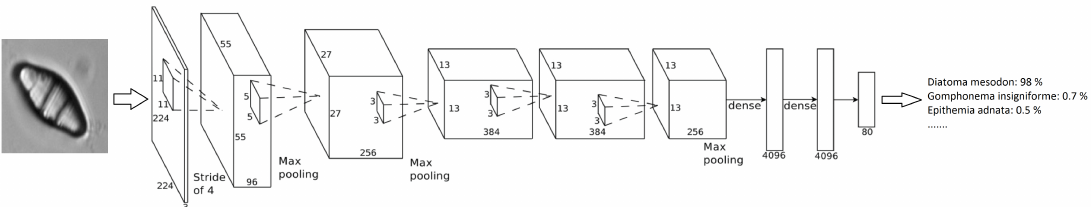
Figure 4. AlexNet Network